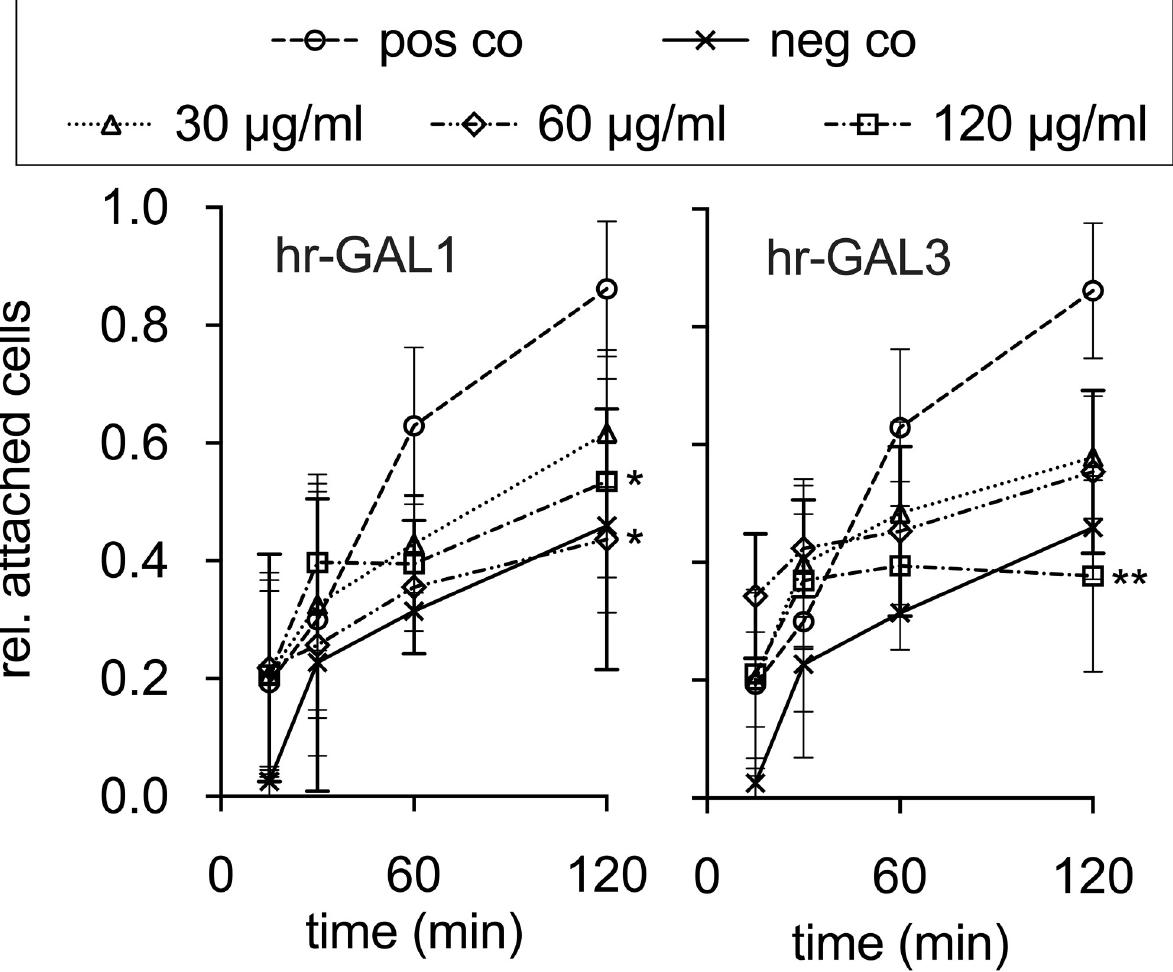
Fig 6. hr-GAL1 and 3 inhibit attachment of HRMEC in vitro . Cell adhesion of HRMEC in the presence of 30, 60 and 120 μ g/ml of hr-GAL1 and 3. Adherent cells were quantified after 15, 30, 60 and 120 min. � positive control (pos co) vs hr-GAL1 or 3; � p < 0.05, (vs hr-GAL1 60 μ g/ml: p = 0.021,